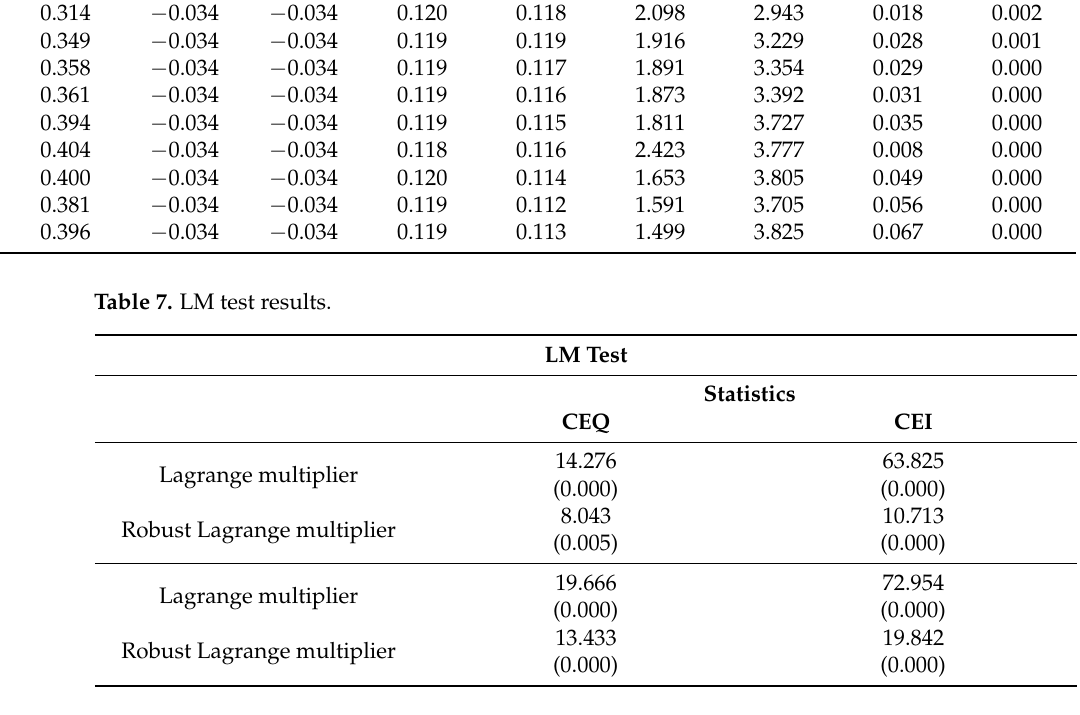
Table 8. Model selection